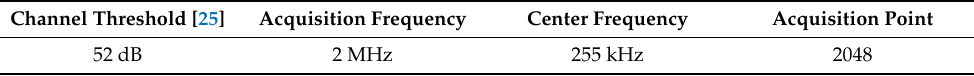
Table 2. Parameter setting related to the acoustic emission (AE) equipment.